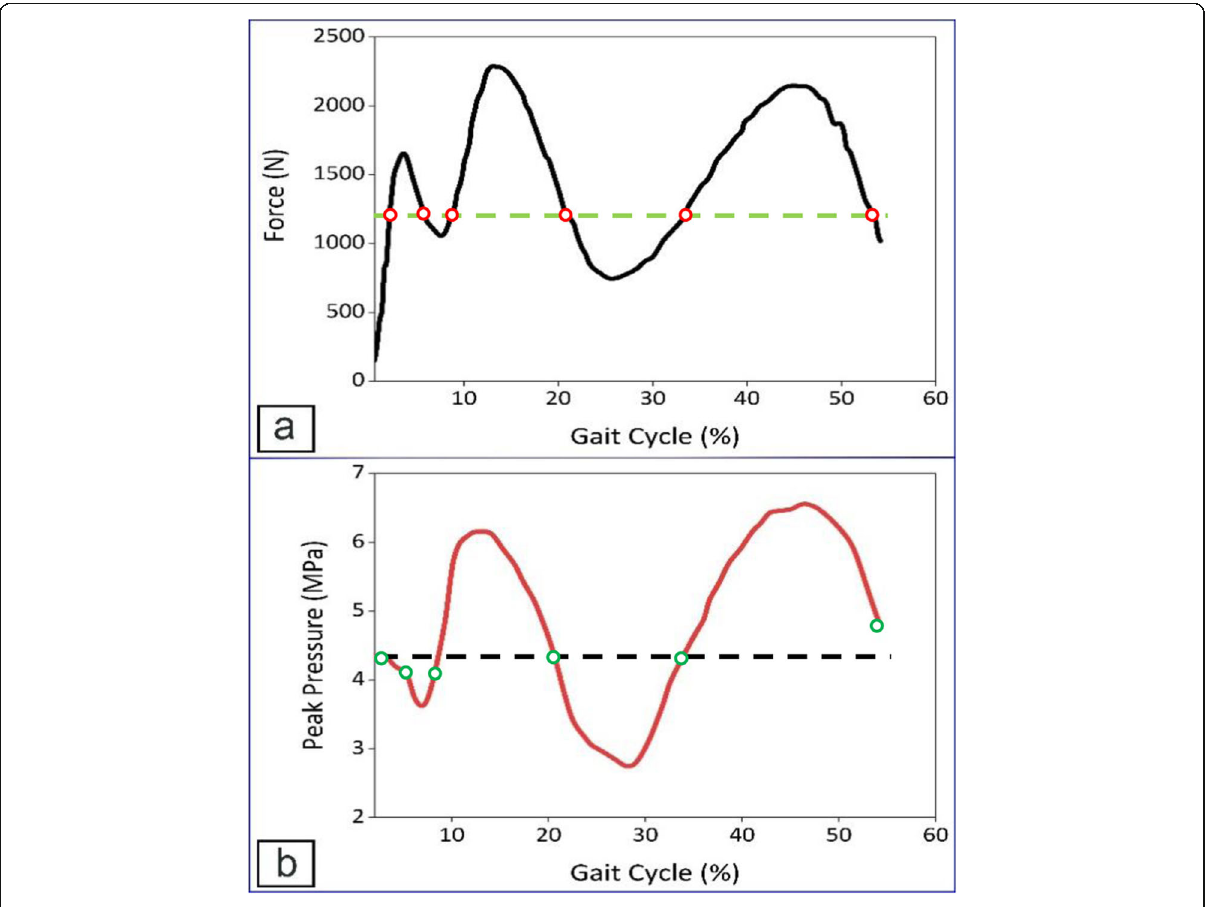
Fig. 16 a input of the knee simulator [25], b measured peak contact pressure in the medial side by Tekscan sensor